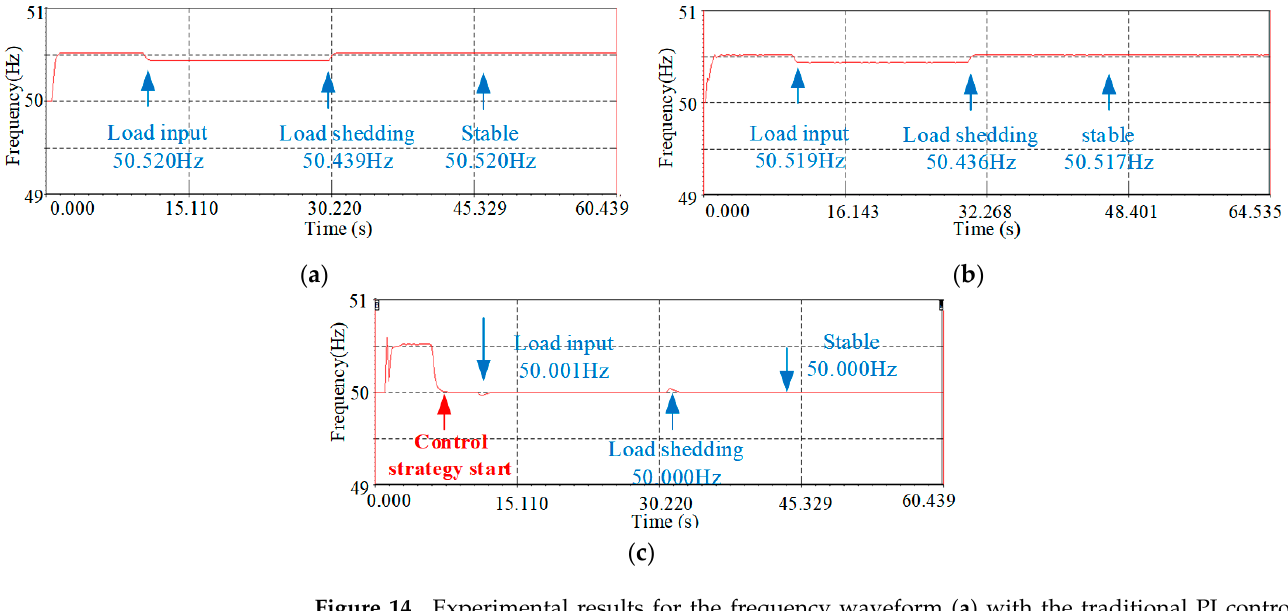
Figure 14. Experimental results for the frequency waveform ( a ) with the traditional PI control strategy; ( b ) with the harmonic and imbalance voltage suppression of multi-inverter parallel VSG; ( c ) with the harmonic and imbalance voltage suppression of multi-inverter parallel VSG adding a secondary control strategy.